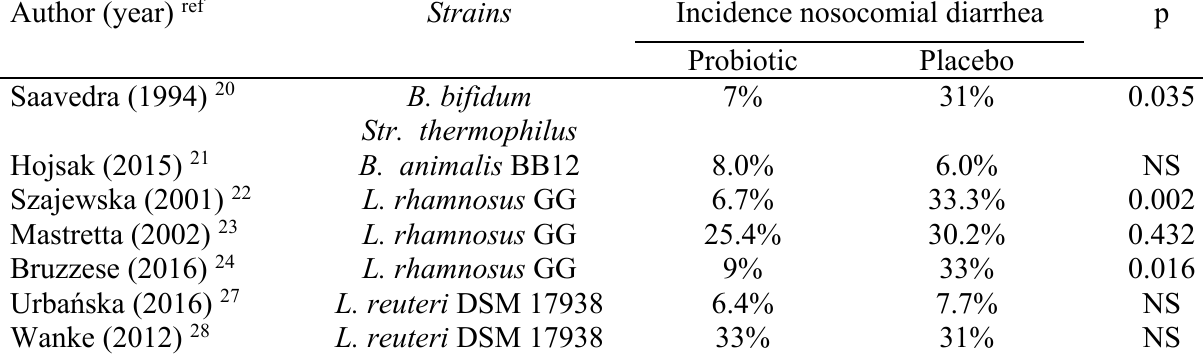
Table 2. Probiotics and prevention of nosocomial diarrhea Author (year)